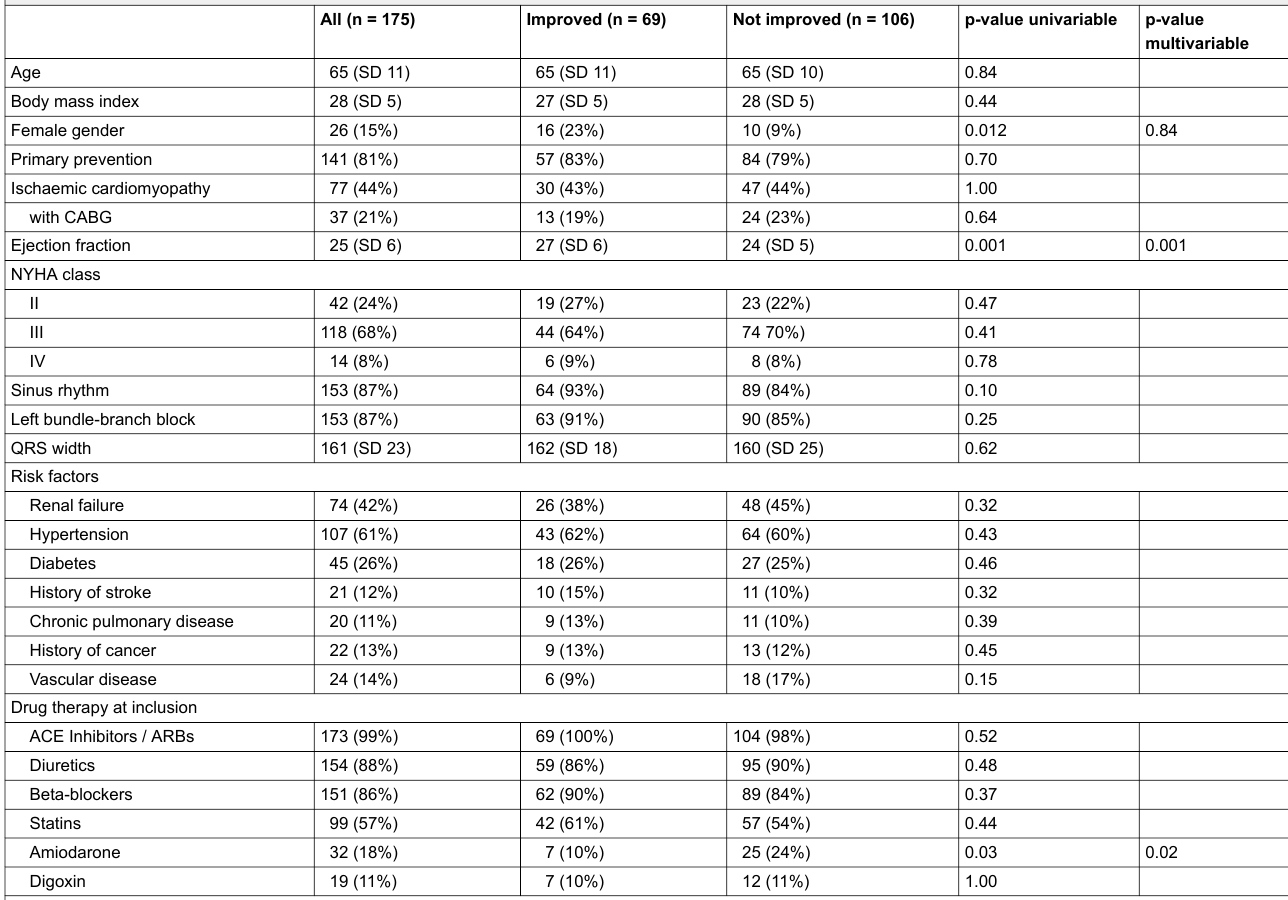
Table 1: Baseline characteristics of patients and predictors of improvement of left ventricular ejection fraction to >40%. All (n =